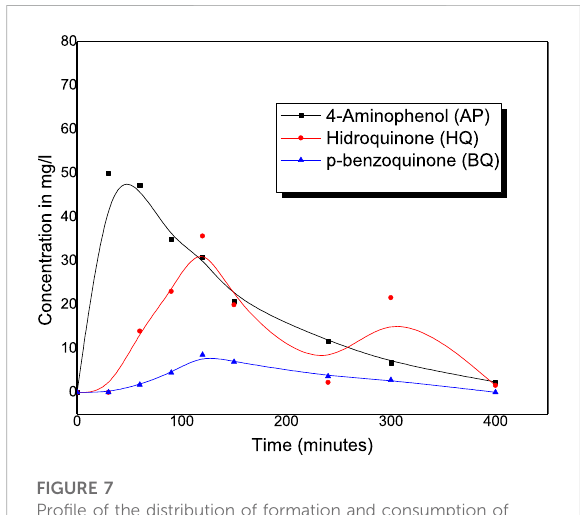
FIGURE 7 Pro fi le of the distribution of formation and consumption of organic intermediates (OI) identi fi ed by liquid chromatography (HPLC)indegradationsamplesofacetaminophen.AP,HQ,andBQ pro fi les are